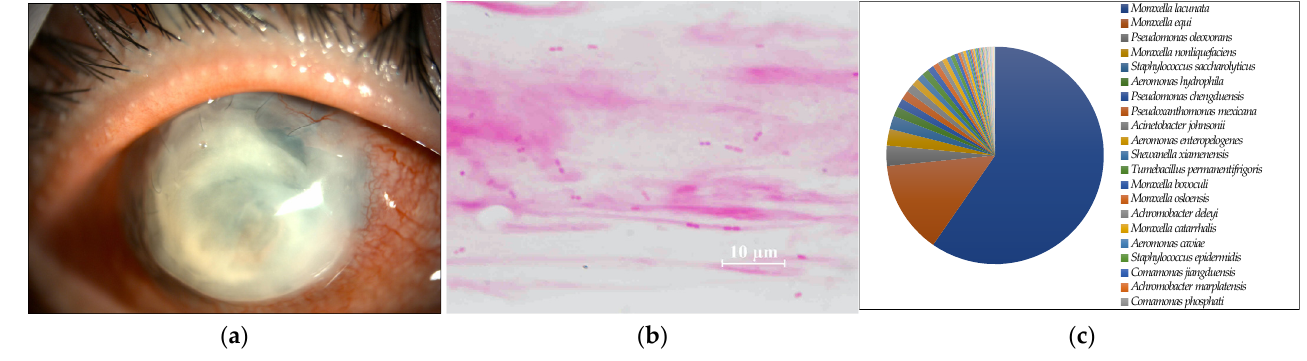
Figure 1. ( a ) Anterior segment photograph. The entire graft is opaque due to infection after corneal transplantation. ( b ) Smear microscopy. Many large Gram-negative rods were detected. ( c ) Nanopore sequencing results (relative abundance) of Case 1. Moraxella lacunata was detected as the dominant species by MinION.